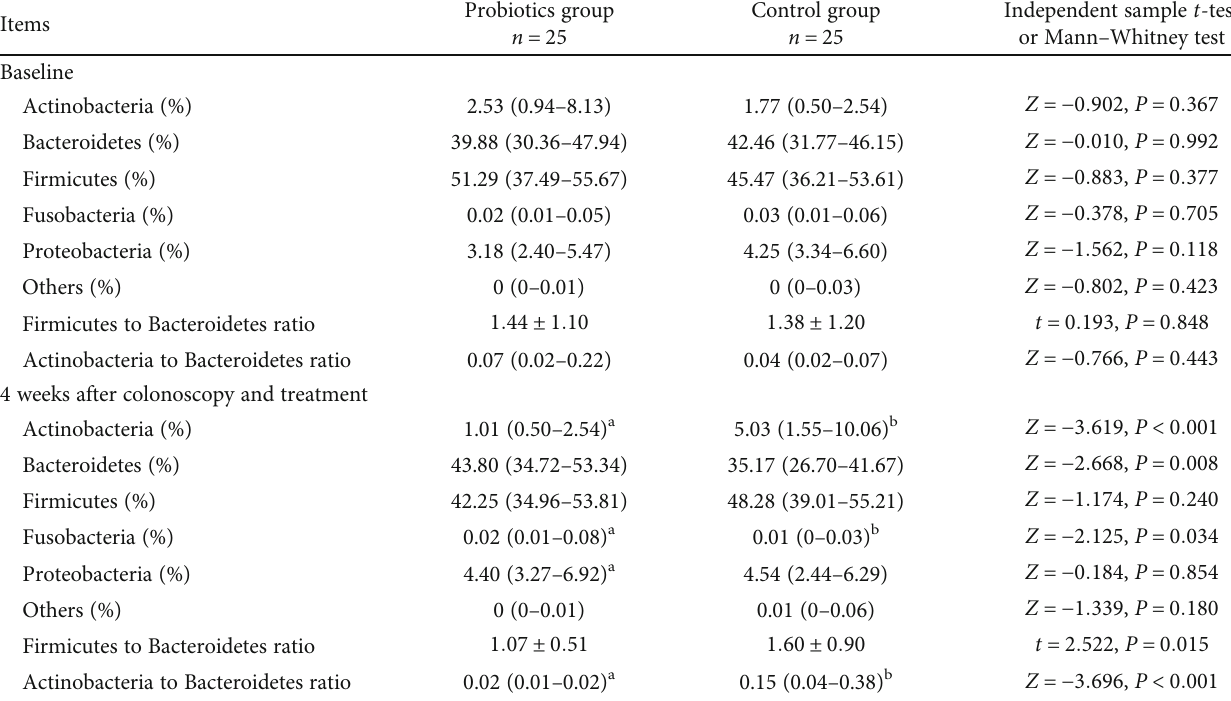
Figure 2: Changes of gastrointestinal symptom rating scale (GSRS). GSRS scores at the time of 2 weeks and 4 weeks after colonoscopy and treatment were signi fi cantly lower than those at the baseline of the probiotics and control groups. But GSRS score at the time of 4 weeks after colonoscopy and treatment was signi fi cantly higher than that at the time of 2 weeks after colonoscopy and treatment in the control group. Table 2: Composition of the gut microbiota at the phylum level (median